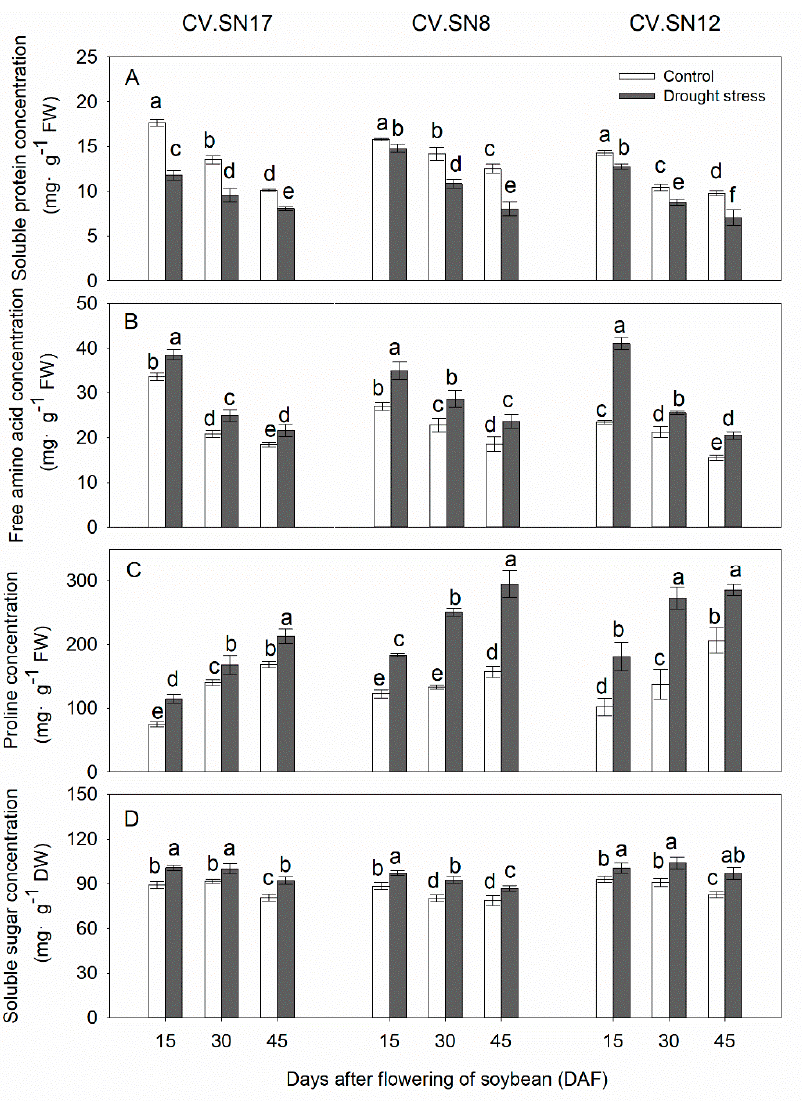
Figure 5. Changes of ( A ) soluble protein concentrations, ( B ) free amino acid concentrations, ( C ) proline concentrations, and ( D ) soluble sugar concentrations in leaves of CV.SN17, CV.SN8 and CV.SN12 under control and drought stress condition. Data show the means ± standard deviation of three independent samples. Di ff erent letters above vertical bars indicate significant di ff erences between means at a p < 0.05 level.